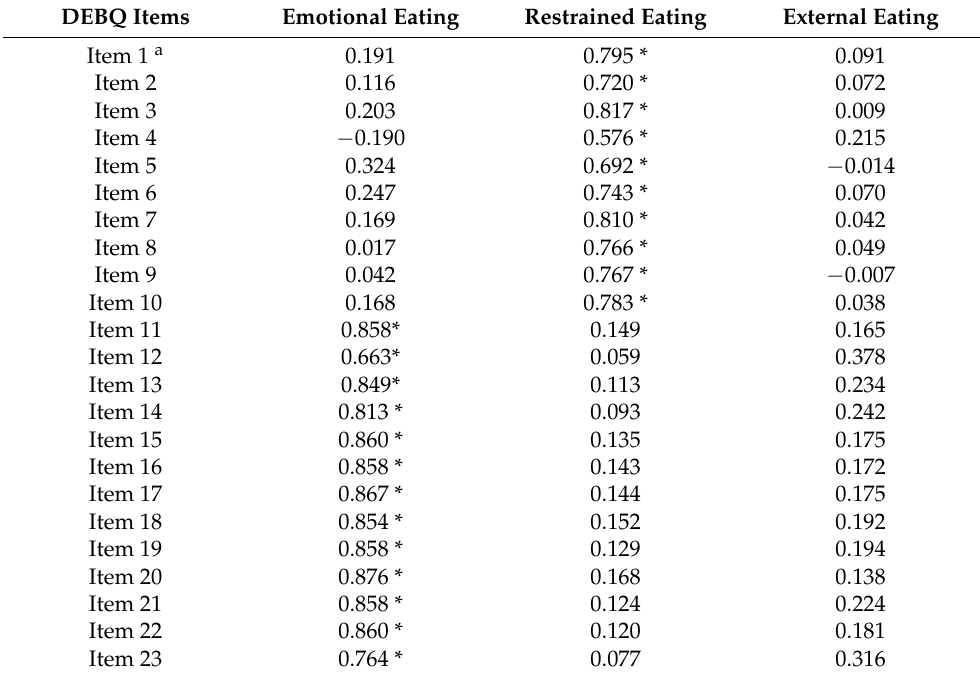
Table 2. Component loadings for DEBQ